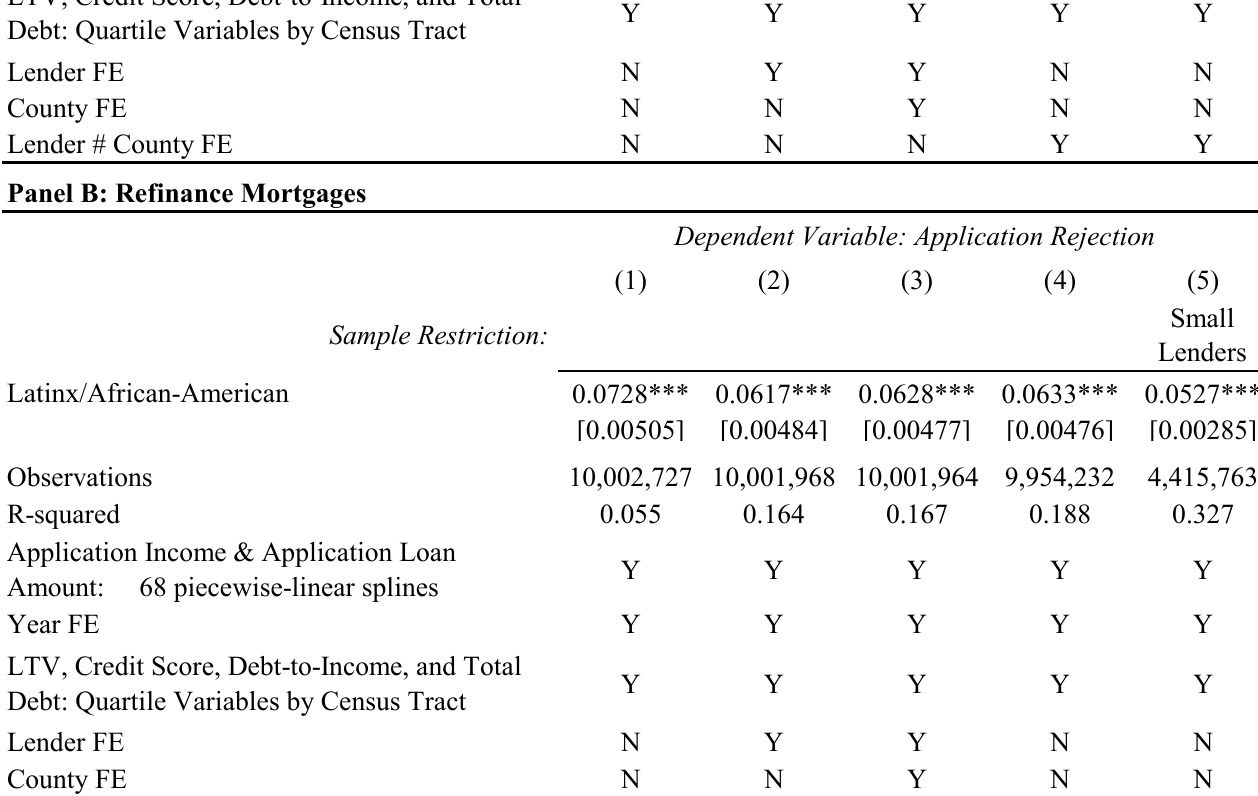
Table 9: Application Rejection Discrimination - Lender & Location Fixed Effects